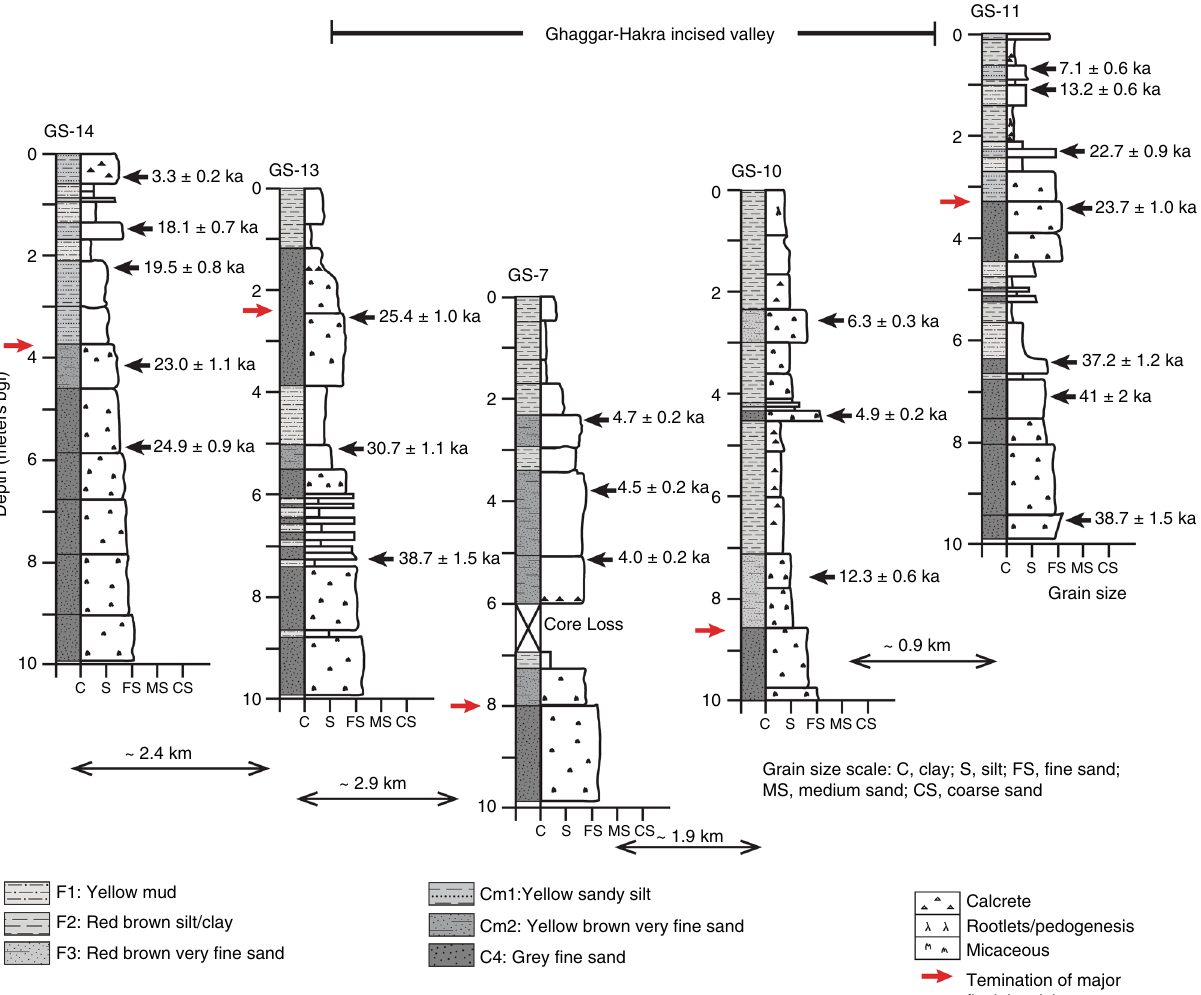
Fig. 7 Stratigraphic panel showing detailed core sedimentology in upper part of GS section across Ghaggar – Hakra palaeochannel at Kalibangan. OSL ages are indicated. Red arrows demarcate top of grey sands indicating termination of major Himalayan fl uvial activity in each section. Sedimentary sections are arranged in elevation. bgl, below ground